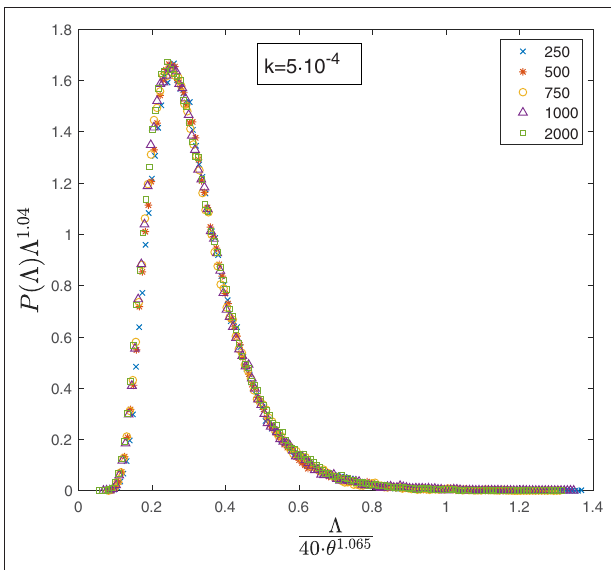
FIGURE 10 | Data collapse for the distribution of the largest cluster P ( 3 ) at k = 5 · 10 − 4 .